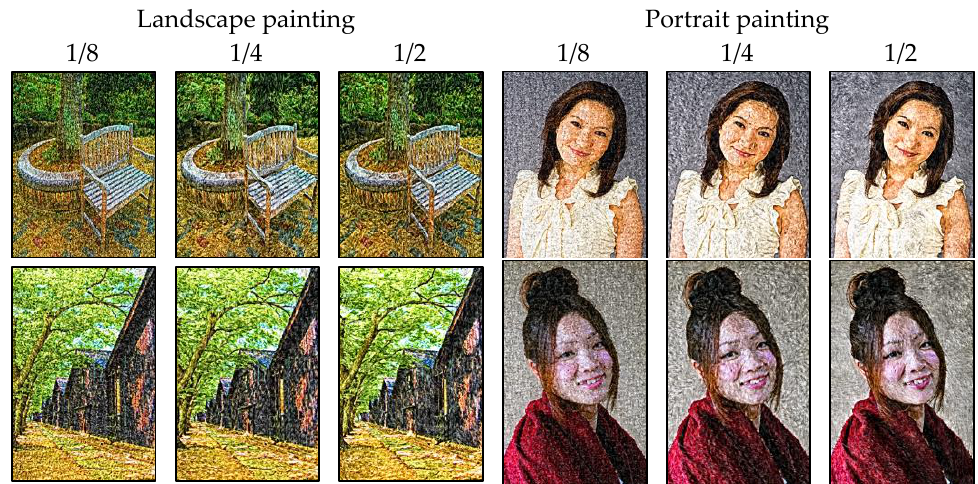
Figure 12. Generated examples of landscape and portrait painting with the movement of 1/8, 1/4, and 1/2.